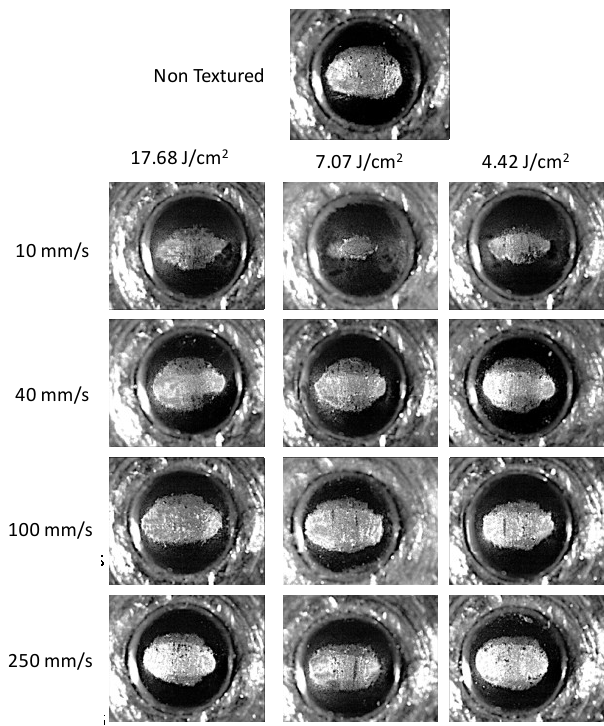
Figure 14. Worn material behavior as a function of V s .